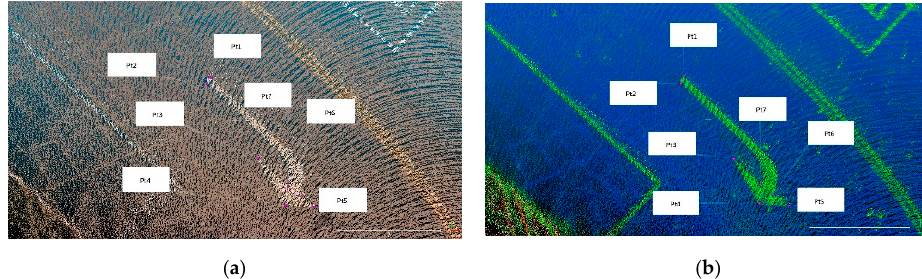
Figure 19. Top views of anchor points in ( a ) color point cloud; ( b ) intensity point cloud.